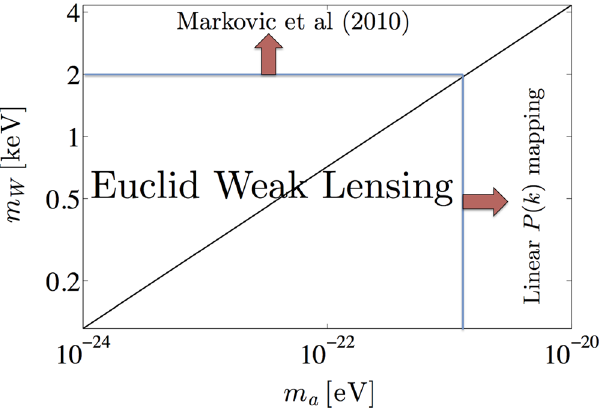
Fig. 51 Mapping between axion and WDM mass that suppress power by a factor of two at the same scale. This can be used to approximately the axion mass constraint possible with Euclid on based on WDM